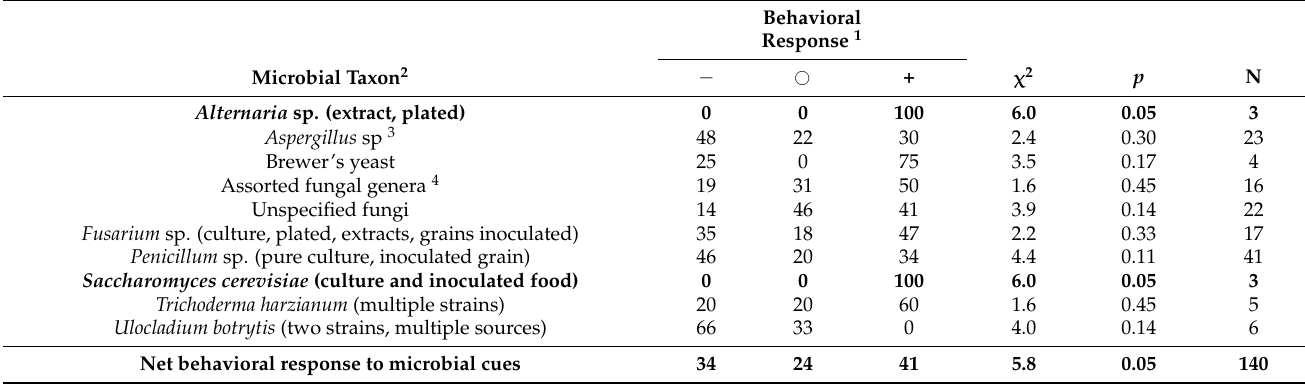
Table 2. Summary of the percent of documented occurrences in the primary literature of attraction (+), repellency ( − ), or no statistical difference from included controls ( ) across 16 stored-product arthropods to each of the following complex (cid:35) blends of microbial